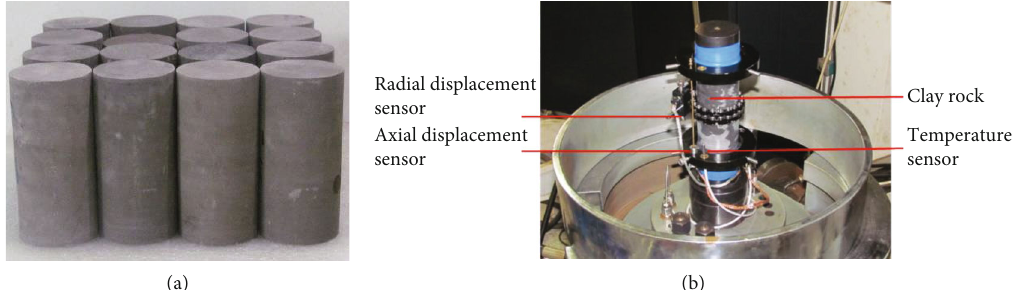
Figure 3: Clay rock samples and sensor installation method (a) Clay rock sample; (b) LVDT and temperature sensor installation.